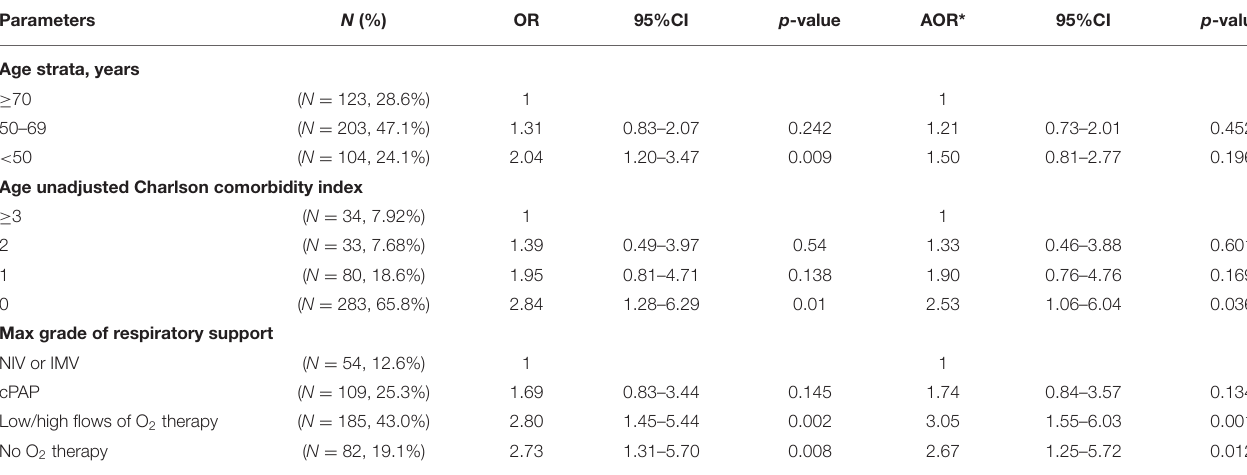
* Adjusted for all the factors shown in the table. Univariable and multivariable logistic regression analysis. OR, odds ratio; AOR, adjusted odds ratio; 95%CI, 95% confidence interval; IMV, Invasive mechanical ventilation; NIV, Non Invasive Ventilation; cPAP, Continuous Positive Airway